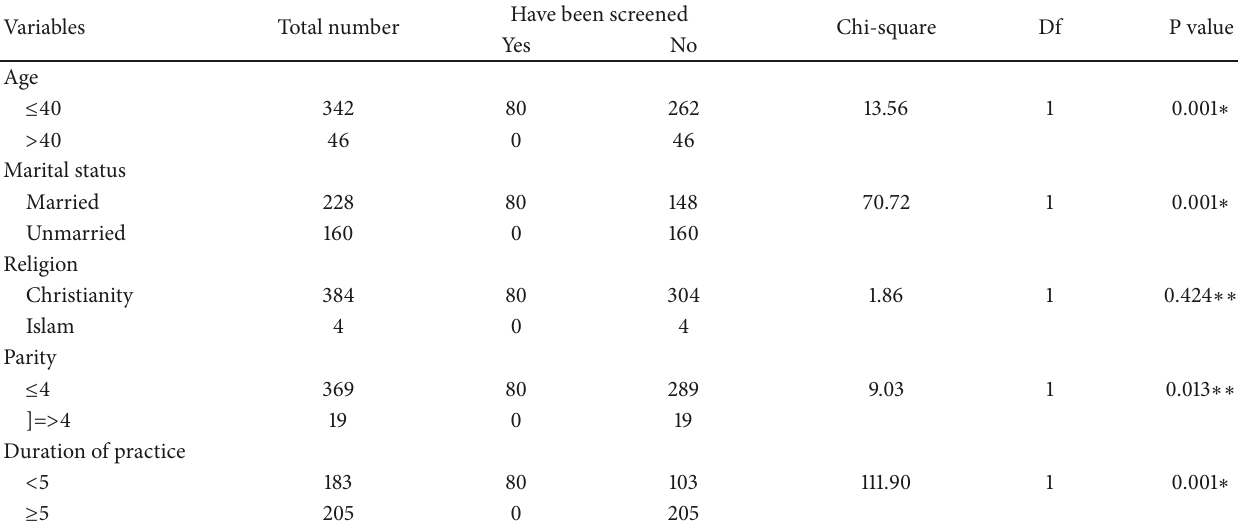
Table 5: Association between sociodemographic variables and utilization of cervical cancer screening